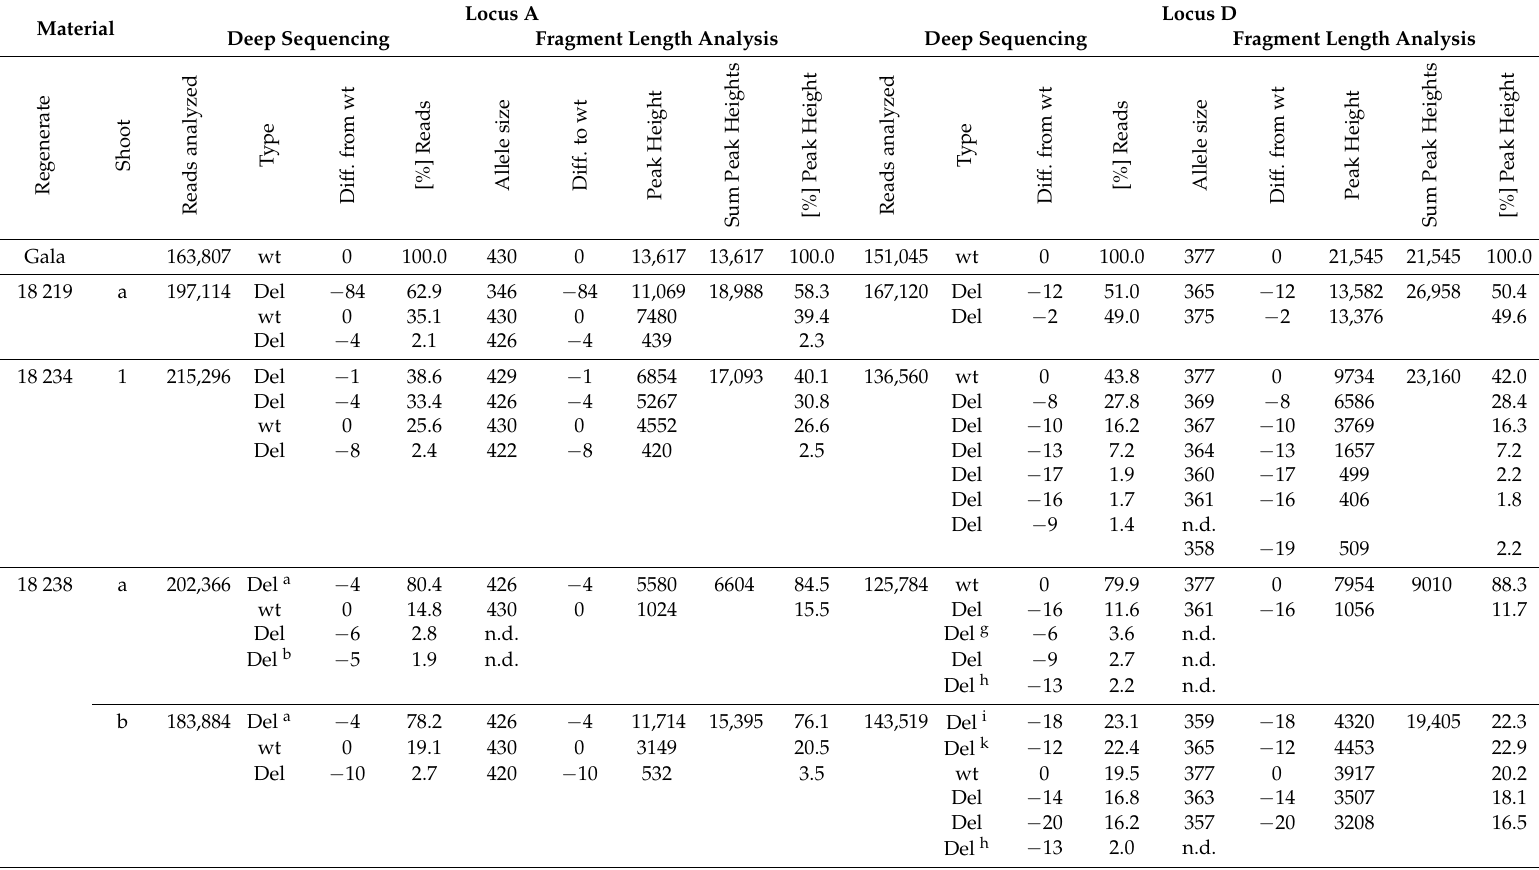
Table 1. Comparison of results obtained by amplicon deep sequencing and fluorescent PCR capillary gel electrophoresis. Locus A Locus D Material Deep Sequencing Fragment Length Analysis Deep Sequencing Fragment Length